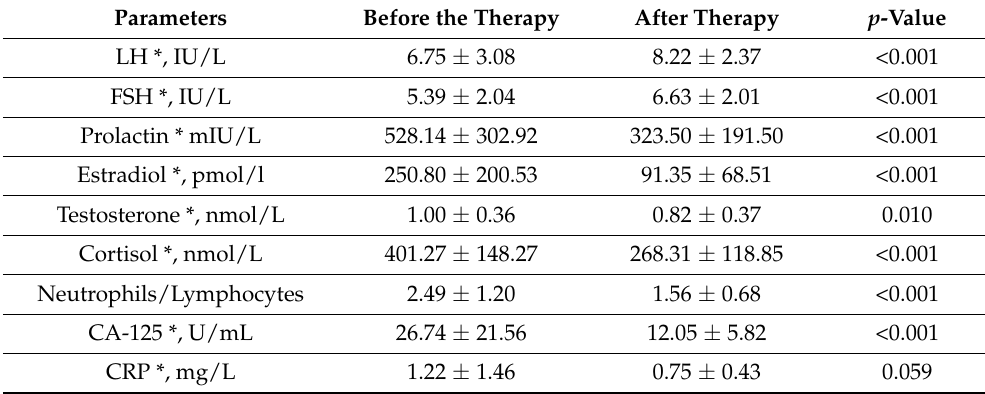
Table 3. Blood levels of hormones and inflammation markers before and after dienogest